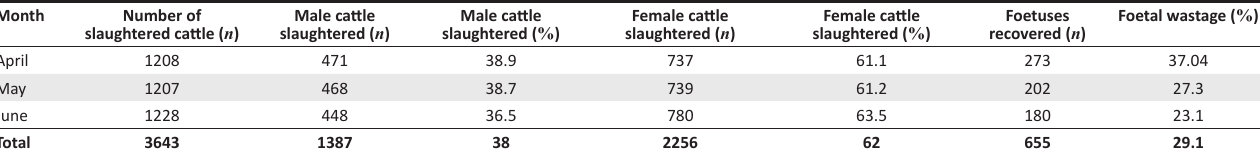
TABLE 1: Slaughtered cattle and foetal wastage in Tanga city abattoir from April to June 2014. Month Number of Male cattle slaughtered cattle ( n ) slaughtered ( n )